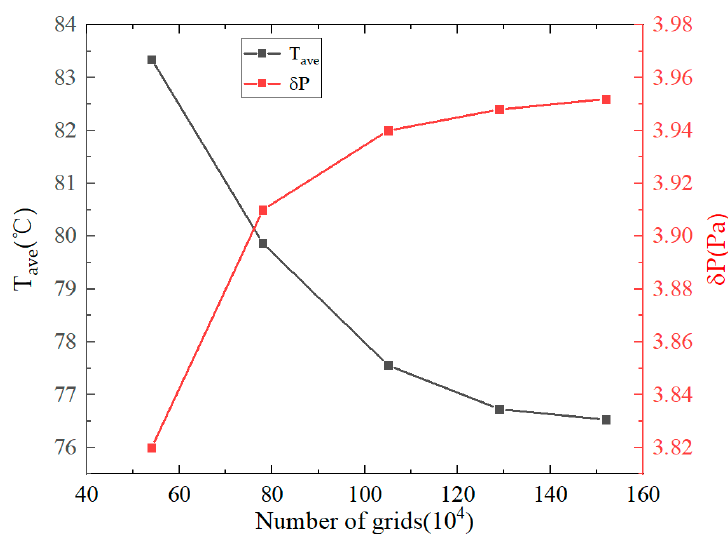
Figure 3. Grid independence test.